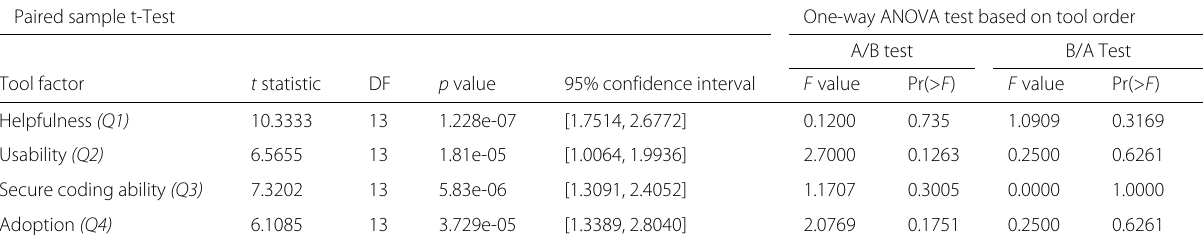
Secure coding ability